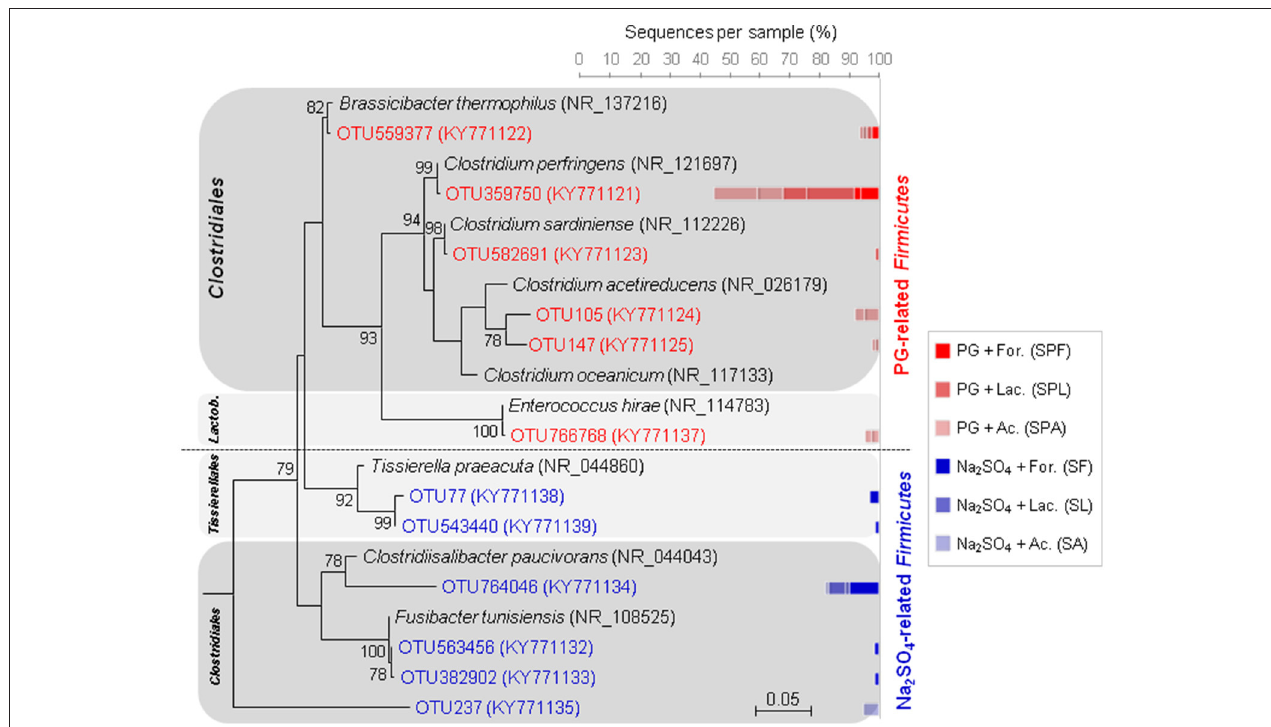
FIGURE 6 | Maximum-likehood (ML) tree based on 16S rRNA gene sequences showing the phylogenetic position of Firmicutes from marine sediment (as inoculum) using different electron donors and sulfate sources (sodium sulfate or phosphogypsum). Representative sequences in the tree were obtained from GenBank (accession number in the brackets). Bootstrap values > 75% are indicated at nodes. The bars represent the relative abundance (in %) of each OTU affiliated with Firmicutes in the enrichment cultures. The blue bars indicate the relative abundance of OTUs in sodium sulfate cultures, whereas the red bars represent the relative abundance of OTUs in PG